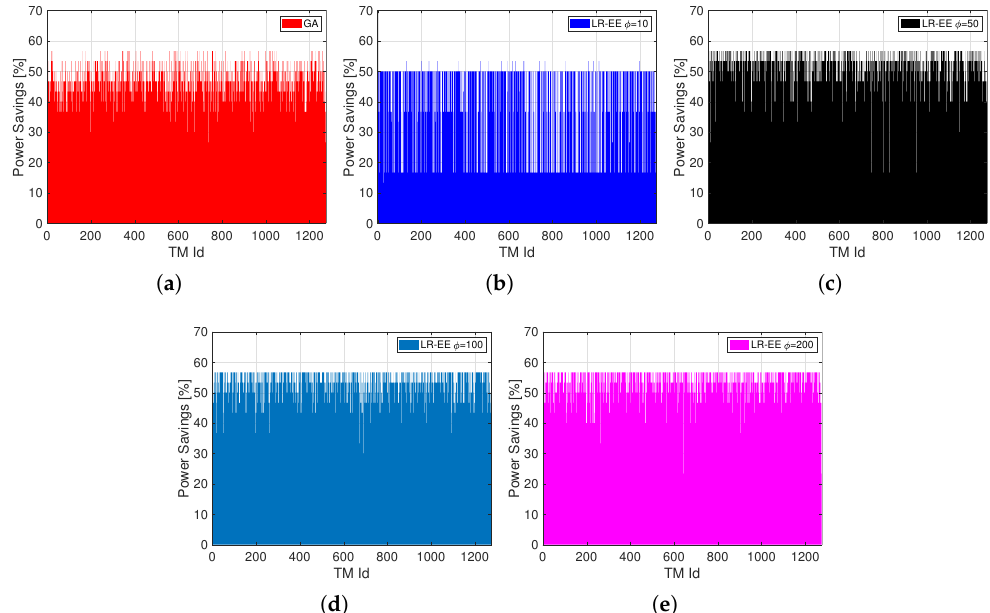
Figure 4. Power savings as a function of the TM Id for GA and LR-EE (TMs are sorted according to their traffic load in ascending order). ( a ) GA [22], ( b ) LR-EE φ = 10 , ( c ) LR-EE φ = 50, ( d ) LR-EE φ = 100, ( e ) LR-EE φ = 200.